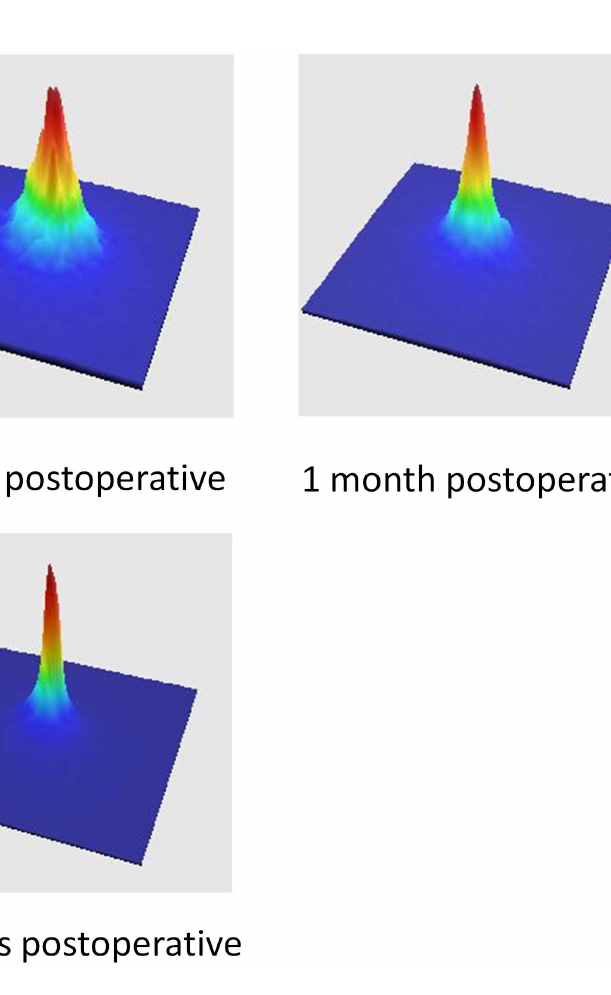
Figure 1. The representative point spread function images of eyes undergoing femtosecond lenticule extraction preoperatively, and 1 week and 1, 3 and 6 months postoperatively.